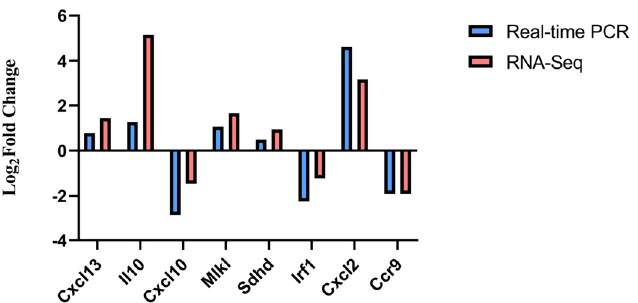
Figure 10. Result of comparing quantitative real-time polymerase chain reaction (qRT-PCR) with RNA-sequencing (RNA-Seq) based on the value of log 2 fold change (FC).